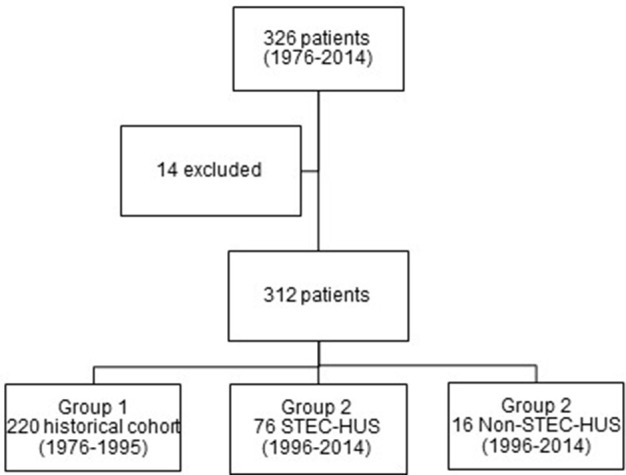
Study collective.